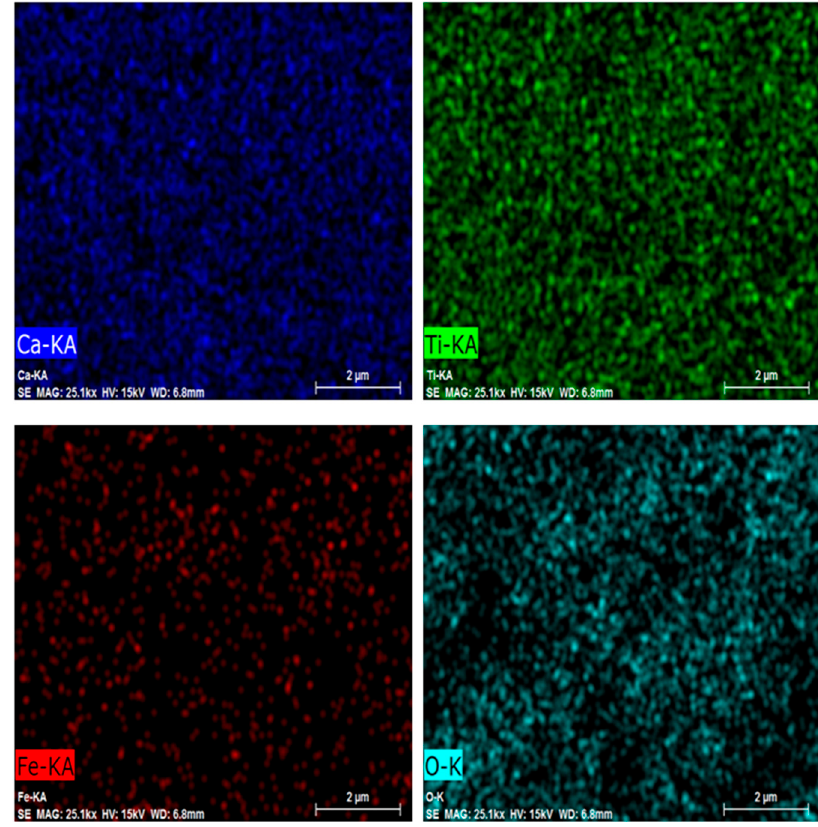
Figure 4. Ca, Ti, Fe, and O elemental mapping using EDS in the CTFO S3 sample.